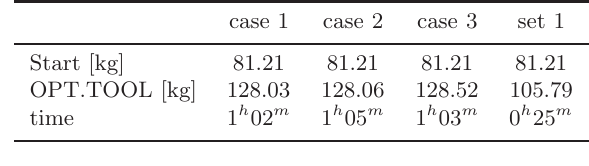
Table 1. OPT.TOOL wing analysis: results for multi-load and single (set 1) load cases.